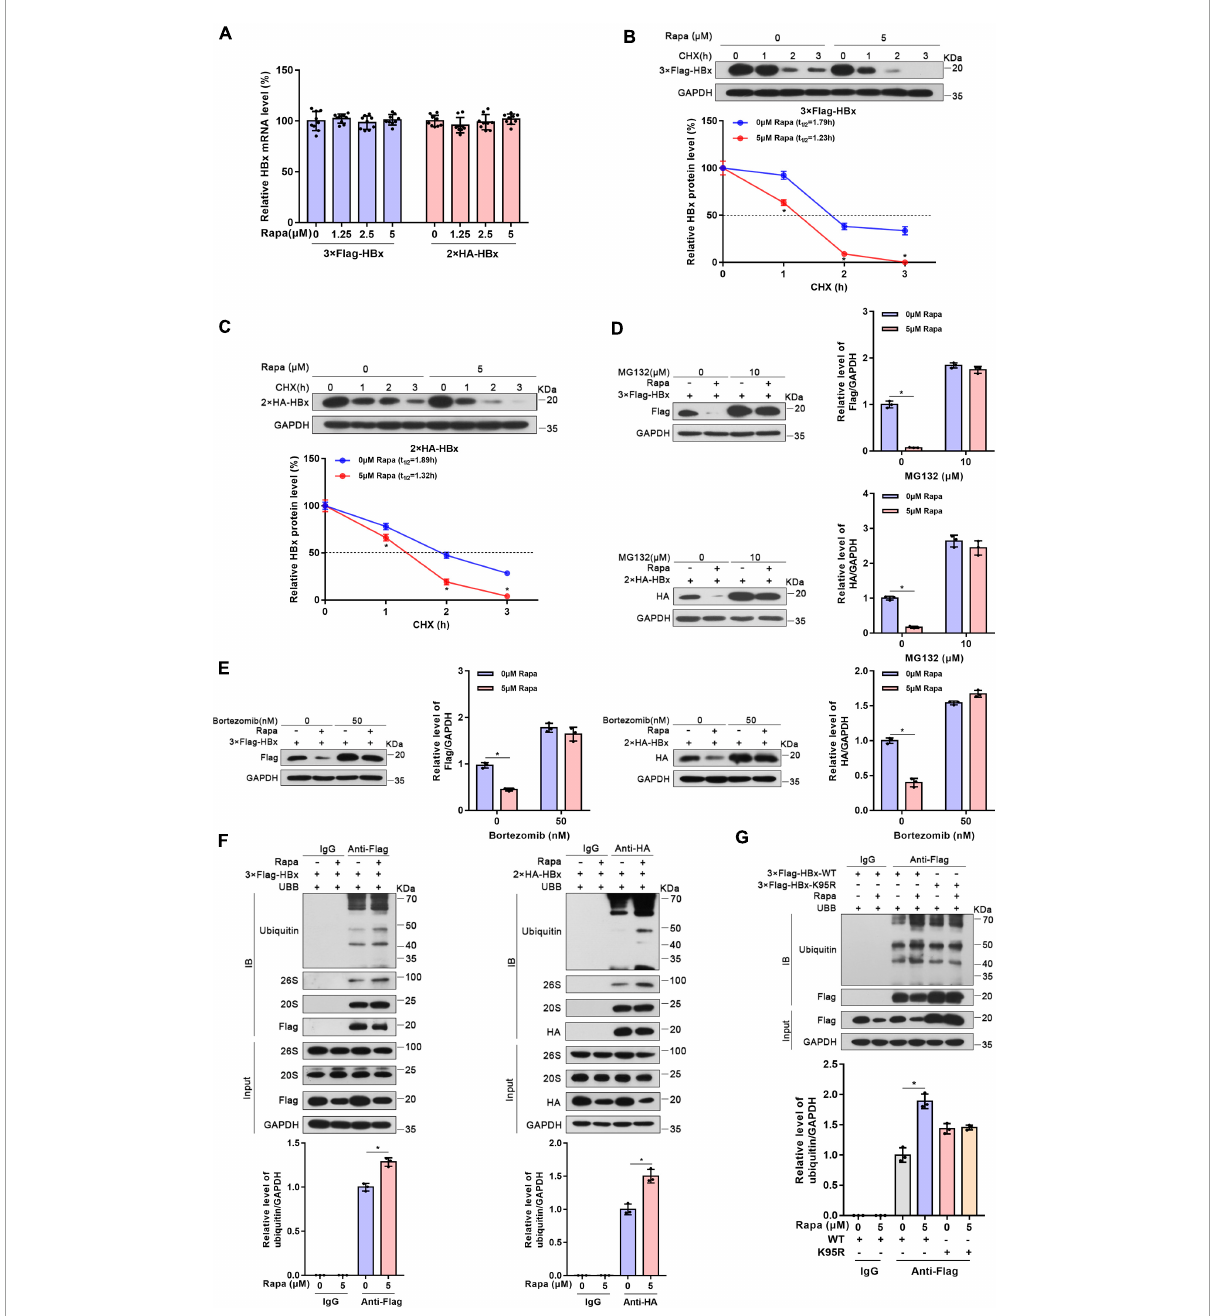
FIGURE2 Rapamycin promoted the degradation of HBx via the ubiquitin-proteasome system. Huh-7 cells were transfected with the corresponding plasmid and then treated with rapamycin for 24 h. (A) The mRNA levels of HBx were examined by real-time PCR using specific primers in Huh7 cells transfected with 3 × Flag-HBx or 2 × HA plasmid. The β -actin mRNA level was used as an internal control. (B,C) Huh-7 cells transfected with 3 × Flag-HBx or 2 × HA-HBx plasmid for 24 h were then exposed to 5 µ M rapamycin and 10 µ g/ml cycloheximide for the indicated times. The levels of the proteins were examined by western blotting analysis, and GAPDH was used as the loading control. (D,E) Ubiquitin-proteasome inhibitor MG132 or bortezomib eliminated the inhibiting effect of rapamycin on HBx. Huh-7 cells transfected with 3 × Flag-HBx or 2 × HA-HBx plasmid were exposed to 5 µ M rapamycin for 24 h, and MG132 or bortezomib was added 8 h before the cells were harvested. The levels of the proteins were examined by western blotting analysis, and GAPDH was used as the loading control. (F) Huh-7 cells were co-transfected with 3 × Flag-HBx or 2 × HA-HBx and Ubb plasmids and then treated with 5 µ M rapamycin for 24 h. Cell lysates were subjected to coimmunoprecipitation with anti-Flag or anti-HA antibody and were then immunoblotted with anti-ubiquitin antibody. (G) Huh-7 cells were co-transfected with 3 × Flag-HBx-WT or 3 × Flag-HBx-K95R and Ubb plasmids and were then treated with 5 µ M rapamycin for 24 h. Protein levels were analyzed after Co-IP. The data are presented as the mean ± SD of three independent experiments. * P <